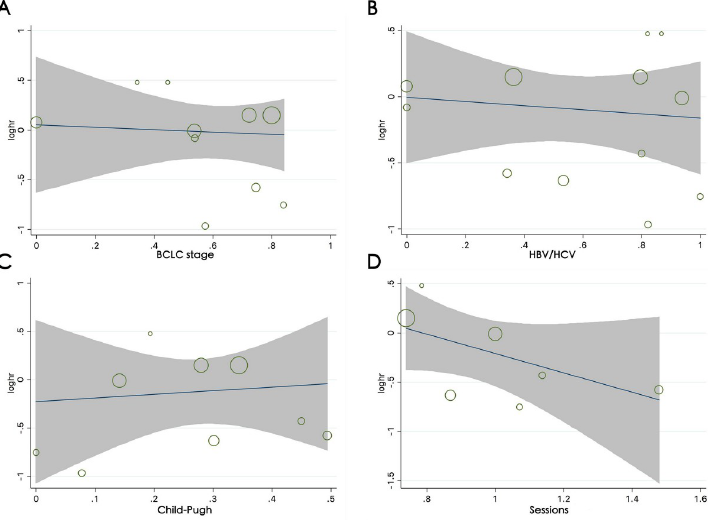
Fig 5. Meta-regression analysis for OS between DEB-TACE and cTACE. Bubble plot with a fitted meta-regression line of the log HR for (A) the baseline proportion of BCLC-B/C, (B) the baseline proportion of HBV/HCV infection, (C) the baseline proportion of Child-Pugh classification A, (D) and the number of treatment sessions. The size of the circles is proportional to the weight of each study in the fitted random-effects meta-regression.